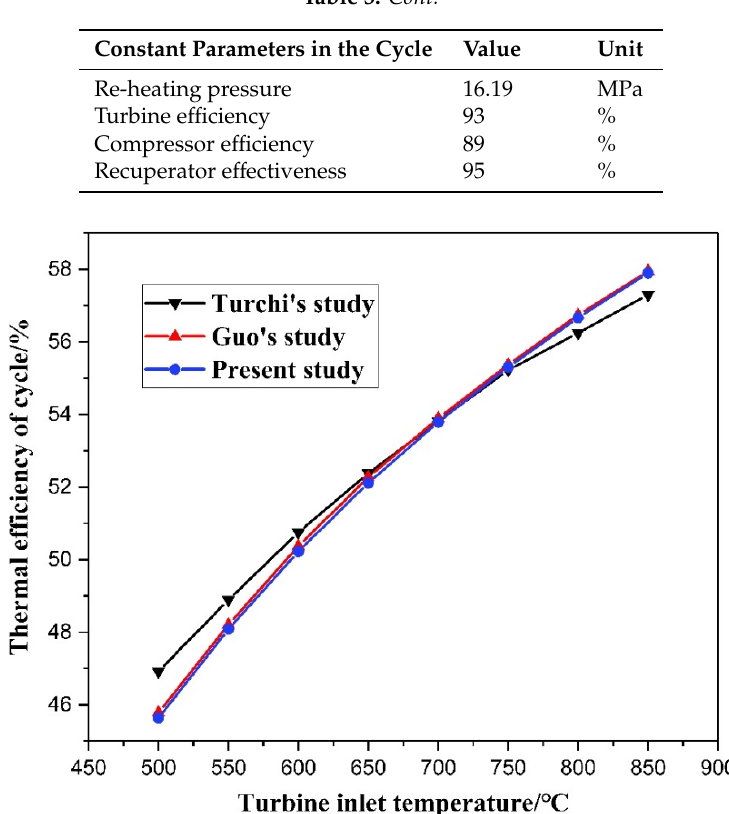
Figure 6. Results of the present study compared to data from Turchi’s and Guo’s studies.